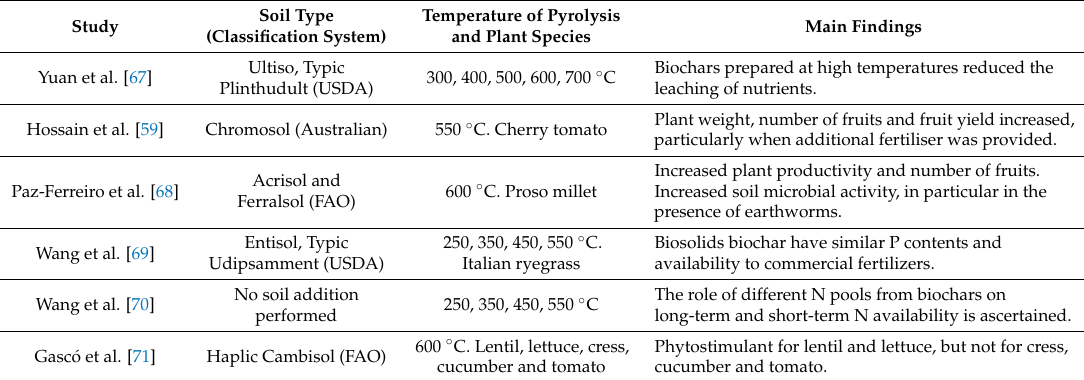
Table 4. Main effects of biochar on soil nutrients and plant